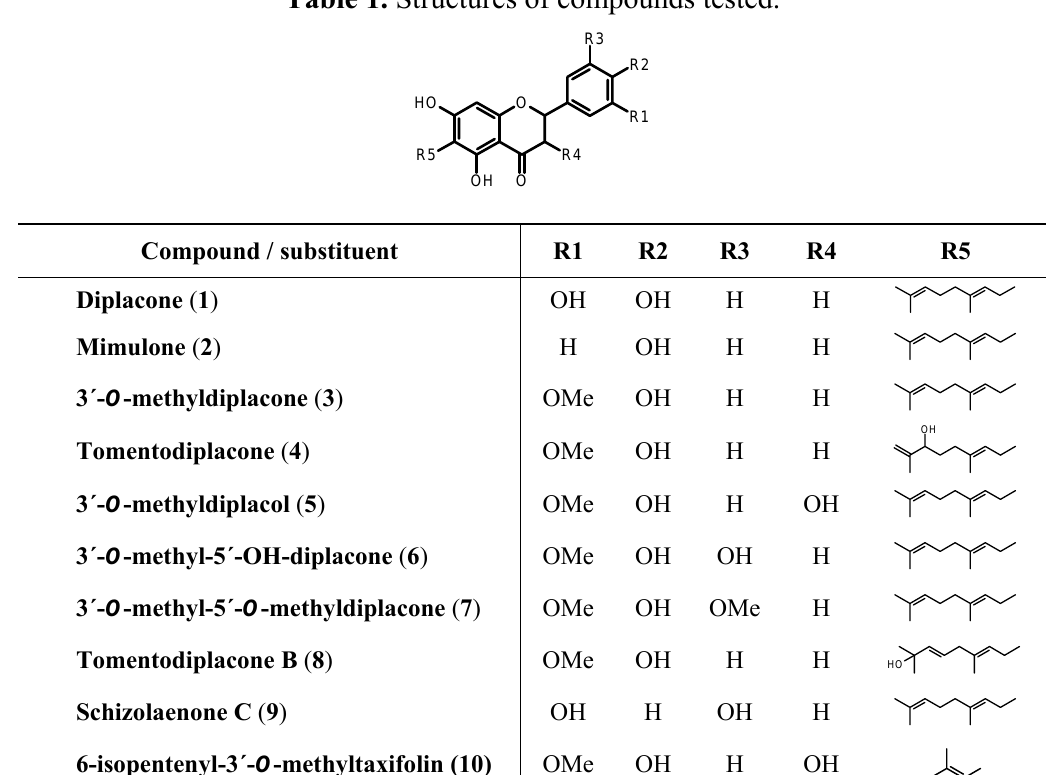
Table 1. Structures of compounds